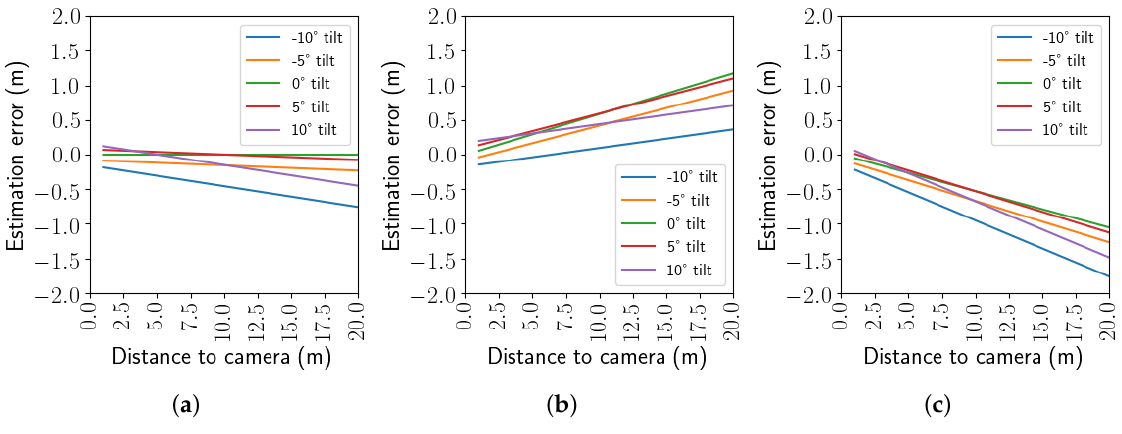
Figure 8. Systematic errors made by the HHm by simplifying the full equation Equation (A3) to Equation (6) in different camera set-ups. The focal length was set to 1000 pixels. ( a ) h 1 = h 2 = 0.9 m, ( b ) h 1 = 0.9 m, h 2 = 0.85 m, ( c ) h 1 = 0.9 m, h 2 = 0.95 m. The systematic errors vary linearly w.r.t. the distance from the camera. A camera tilt ( | θ | > 0 ◦ ) or h 1 < h 2 contributes to an underestimation of the estimated distance, notably for objects further away from the camera. When h 1 > h 2 , the true distance is similarly